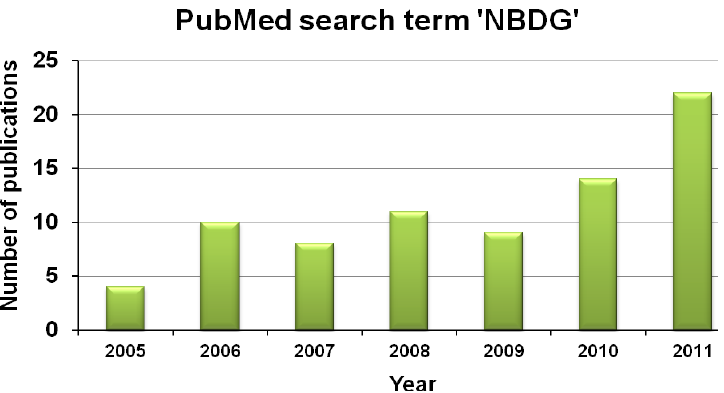
Figure 11. Histogram comparing research publications for 2-NBDG and 6-NBDG since the year 2005, according to PubMed (US National Library of Medicine National Institutes of Health). However, it should be noted that in 2011, there were 1,740 publications that